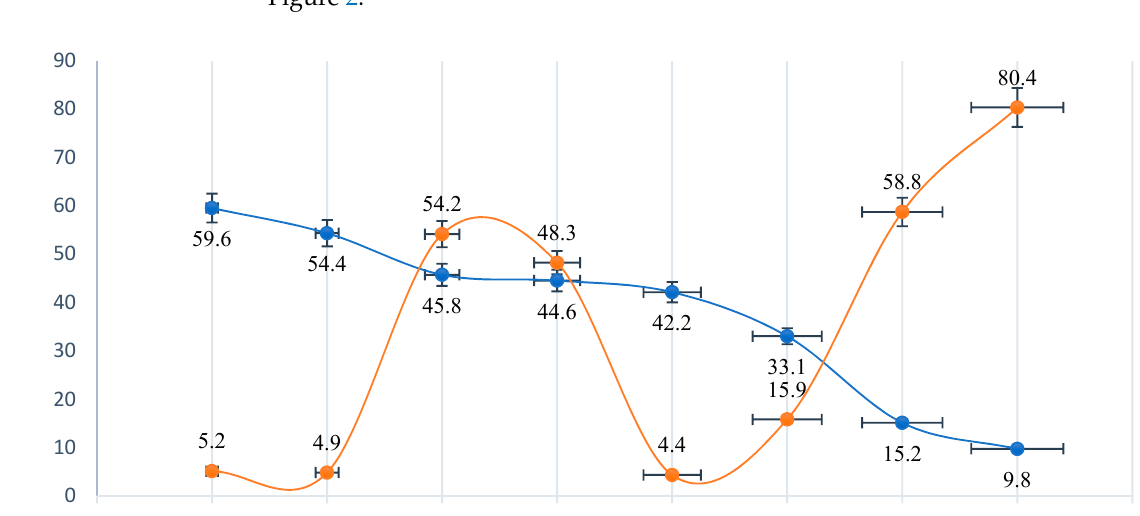
Figure 2. Graphical distribution for media consumption and media reliability for Generation Z. Own elaboration.